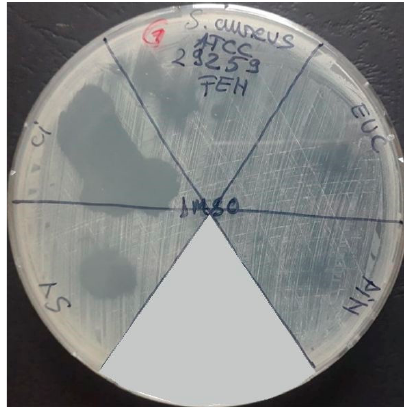
Figure 3. The aspect of the inhibition zones expressed by the Gram-positive strain Staphylococcus aureus ATCC 25923 in the presence of tested EO at 1/10 dilution in DMSO; FEN (fennel EO); SV (sage EO); EUC (eucalyptus EO); CI (thyme EO); PIN (pine EO).